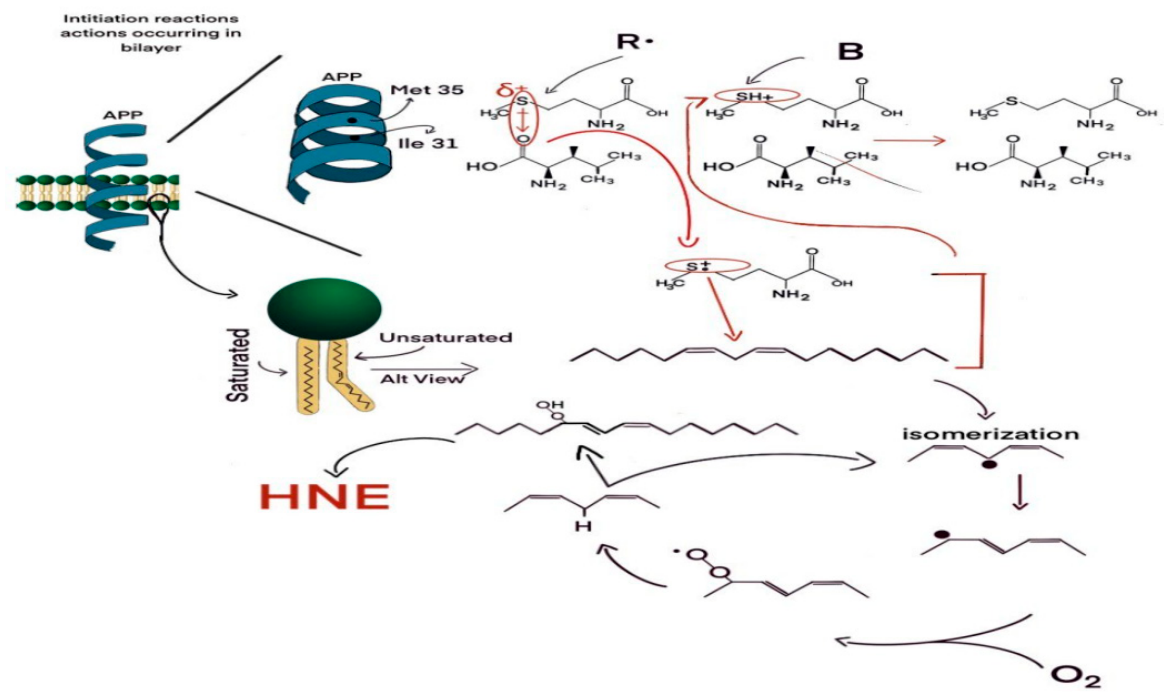
Figure 1. Proposed mechanism for formation of the highly reactive and neurotoxic product of lipid peroxidation, 4-hydroxynonenal (HNE).